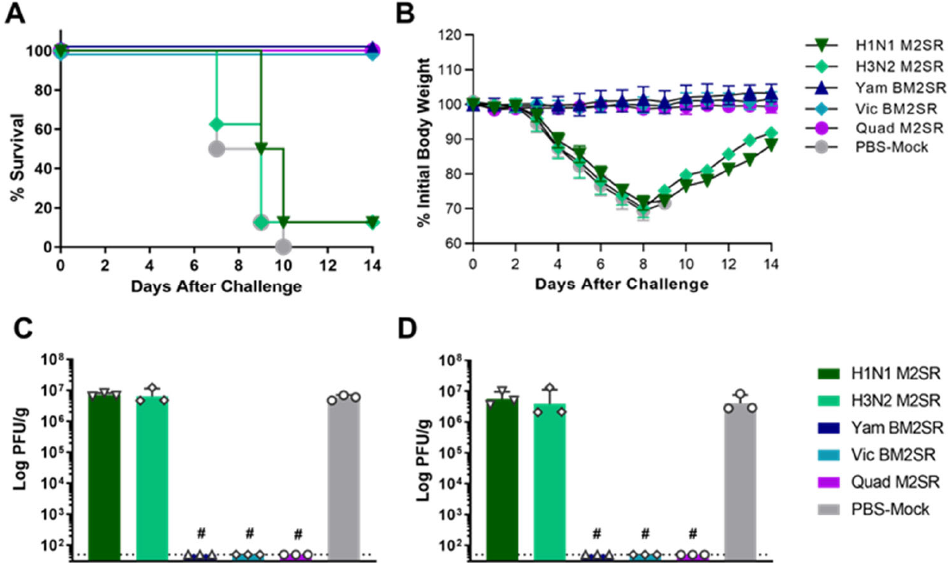
Figure 4. Survival and organ titers of M2SR vaccinated mice following challenge with B/Victoria influenza virus. Mice were vaccinated with indicated vaccines, as described in Materials and Methods. Six weeks following the final vaccination, mice were challenged with 20 MLD 50 of live, wildtype B/Malaysia/2506/2004 (Victoria lineage). Survival ( A ) and body weight changes ( B ) were monitored for 14 days after the challenge. Lung ( C ) and nasal turbinates ( D ) were collected from 3 mice per group on day 4 post-challenge. Viral loads in samples were determined by a plaque-forming assay, and the open faced symbols (e.g., triangles, diamonds, circles, etc.) represent virus titers from individual mice within the group, while colored bars represent the mean titer for the indicated group. The detection limit of the assay was 50 PFU/g and is shown with a horizontal dashed line. Groups that were significantly different from PBS-mock groups are indicated: # p < 0.0005 as compared by unpaired t